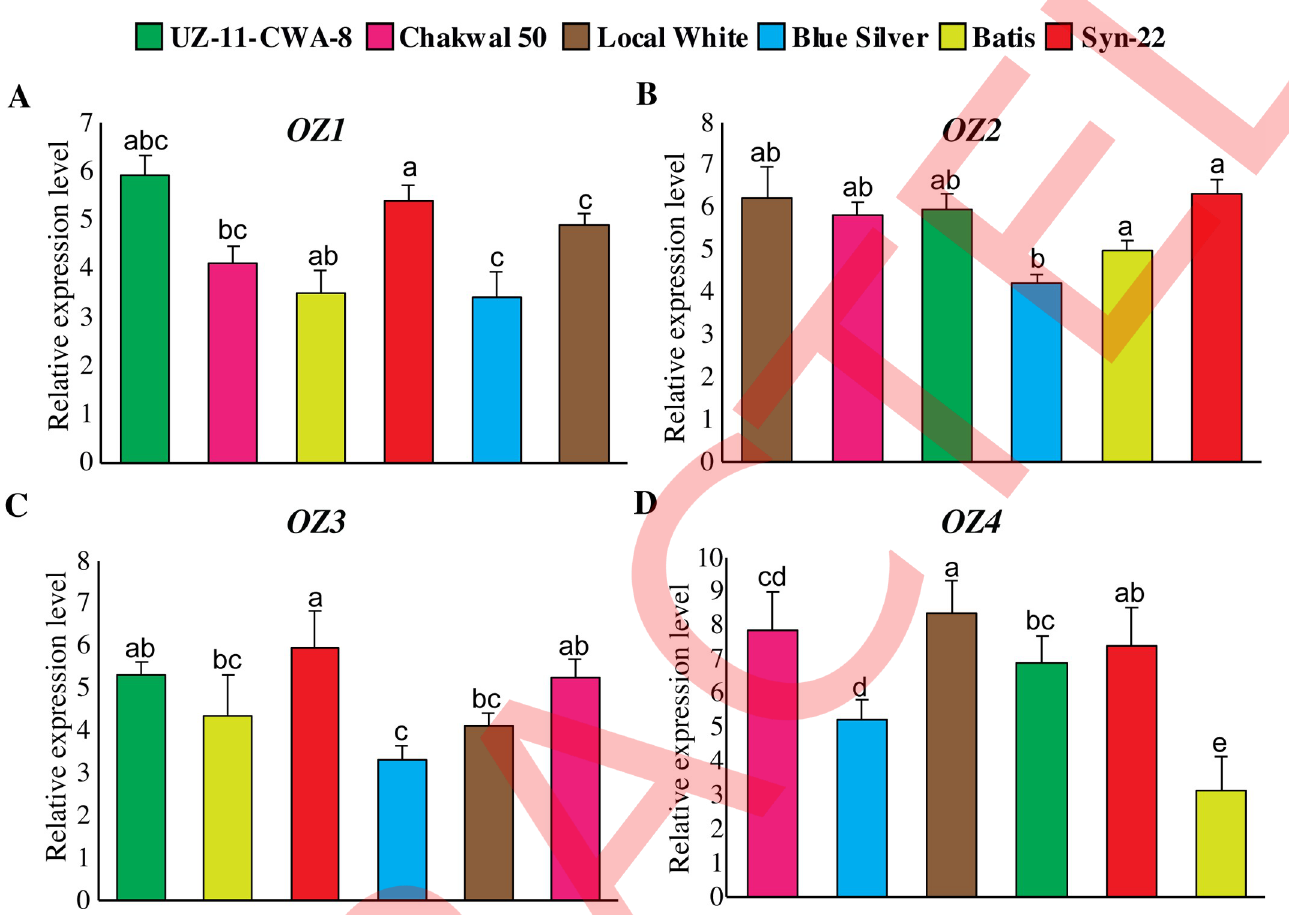
Fig 5. Measurements of gene expression of OZ1 by qRT-PCR. The relative gene expression of DEGs by qRT-PCR is represent by bars with standard errors in three independent experiments. Least Significant Difference (LSD) test was used. Different lowercase letters indicate significantly differences at P � 0.05.